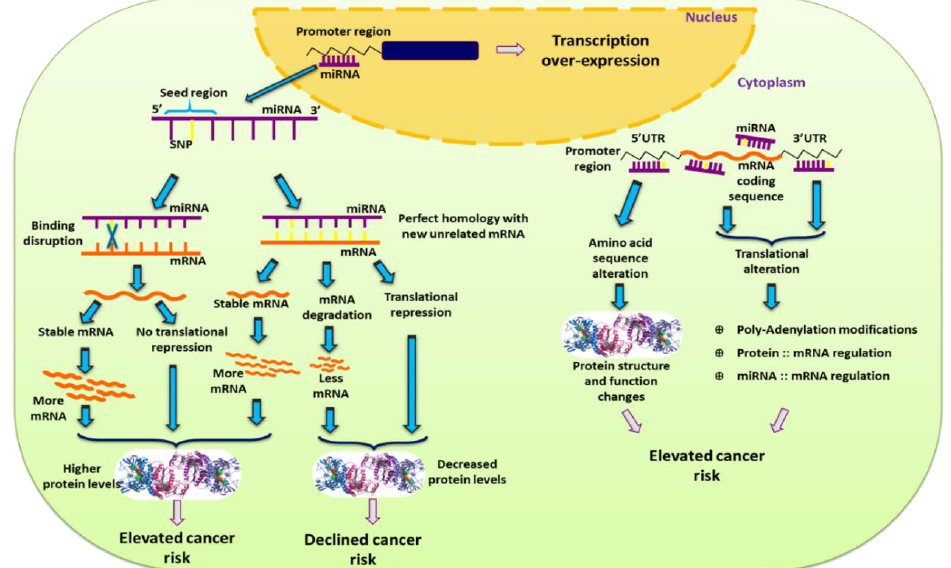
Figure 1. Effect a single nucleotide polymorphism (SNP) exerts in development of cancer risk based on its location in